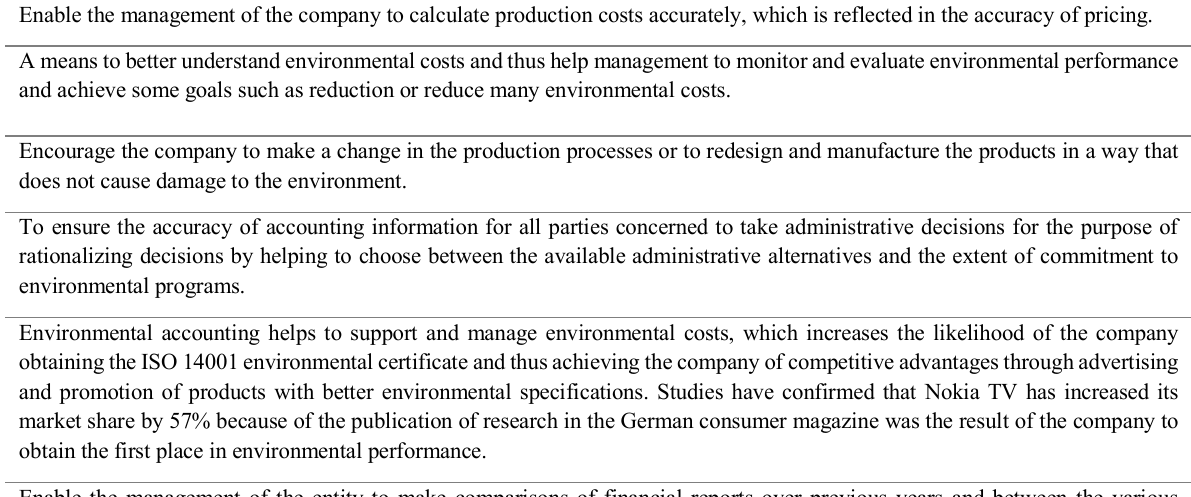
Table1: Advantages of environmental